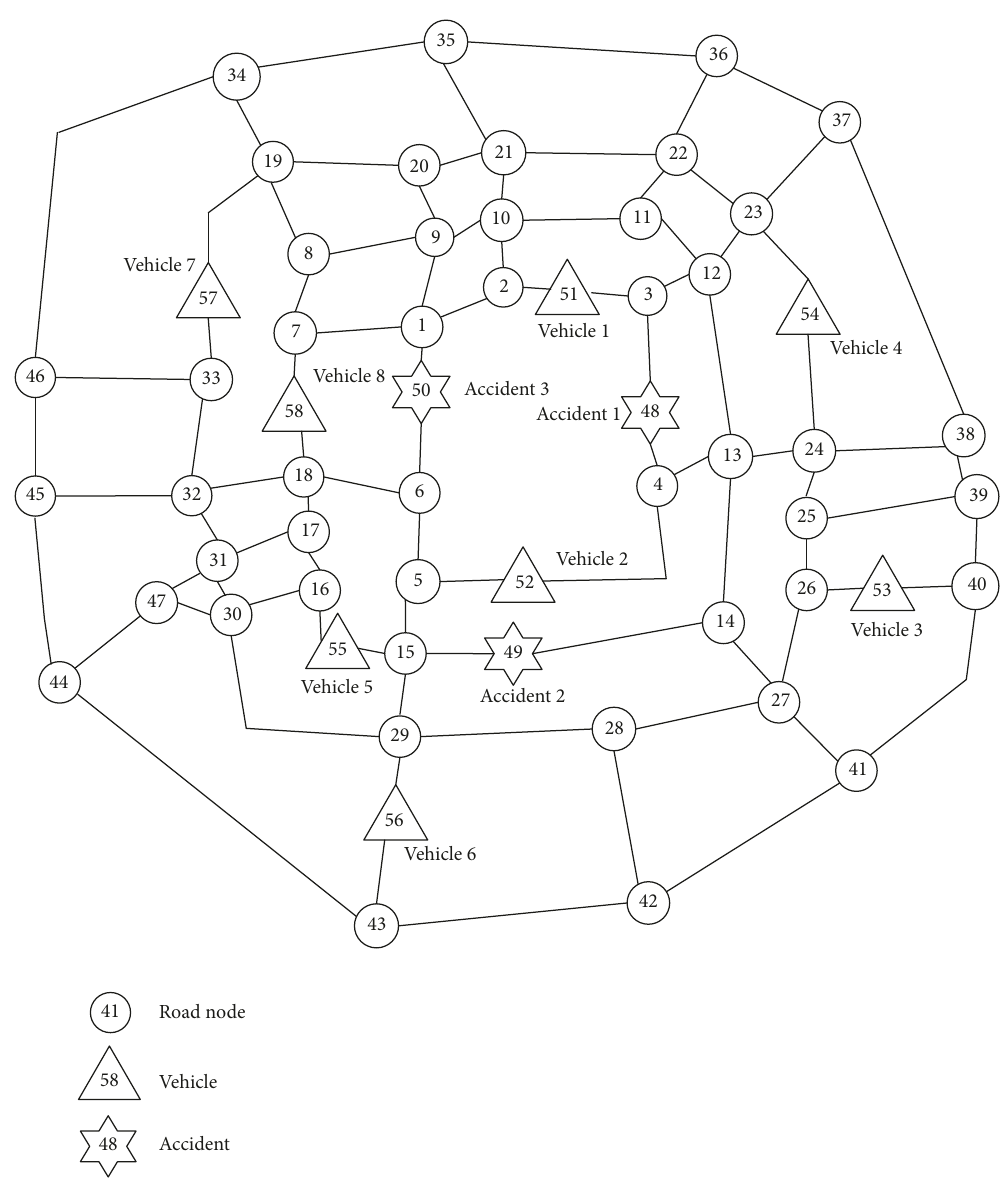
Figure 5: Distribution of the accidents and emergency vehicles.